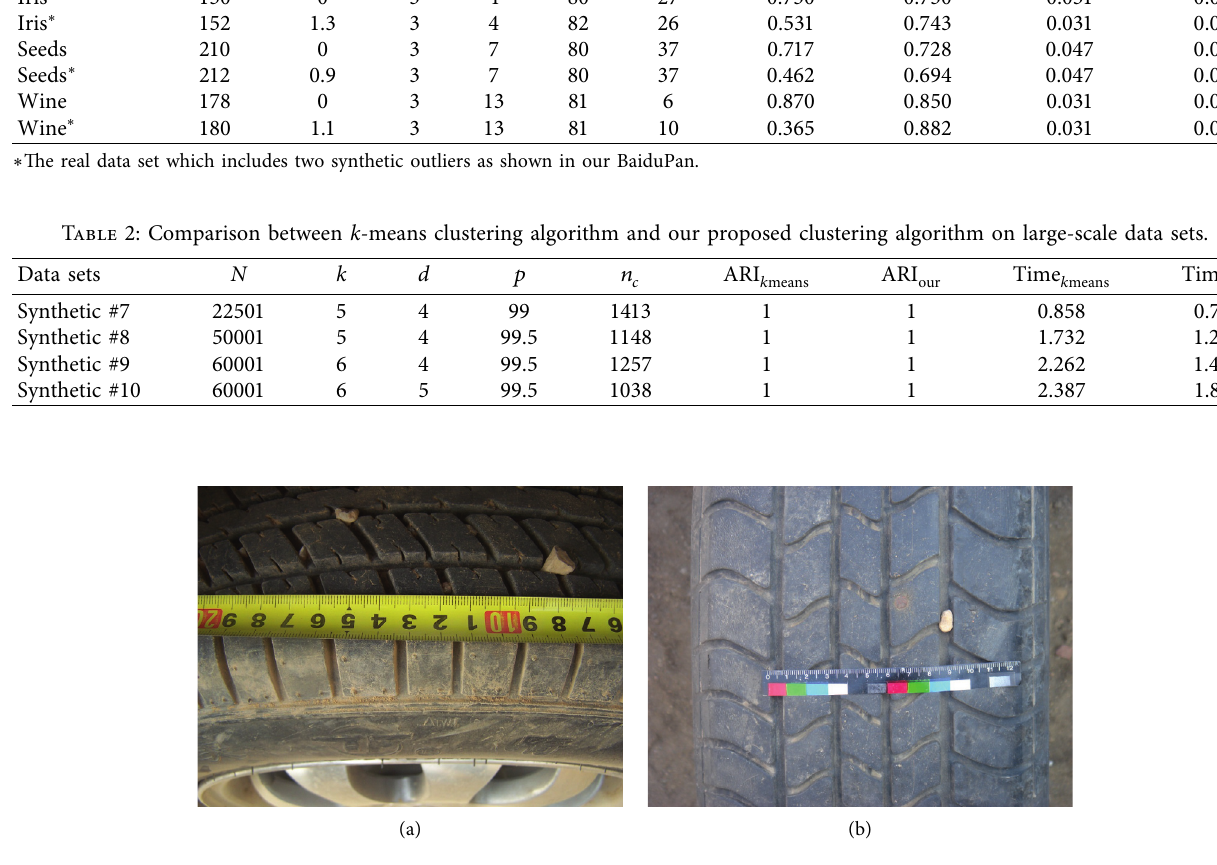
Figure 4: Application of tyre inclusion identification. (a) Tyre #1. (b) Tyre